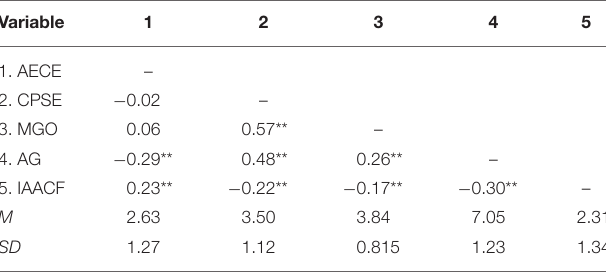
TABLE 2 | Simply moderation for academic grades.